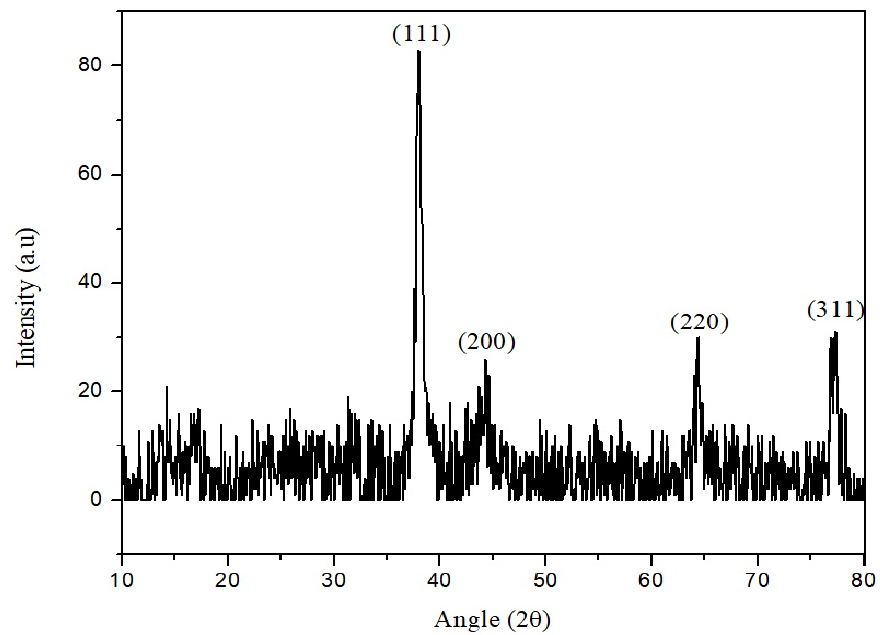
Figure 8. XRD pattern of the biosynthesized silver nanoparticle (AgNPs). FTIR results of the AgNPs are given in Figure 9, which show the presence of different functional groups. FTIR spectra found that a different peak at 3300 cm − 1 is associated with OH stretching corresponding to alcohols, 2913 for C-H stretching of alkene, 2160 for C ≡ C stretching of alkyne and 1622 for C=C stretching of alkene. These functional groups were probably the capping layer of the plant secondary constituent, which is responsible for stable nanoparticle formation.